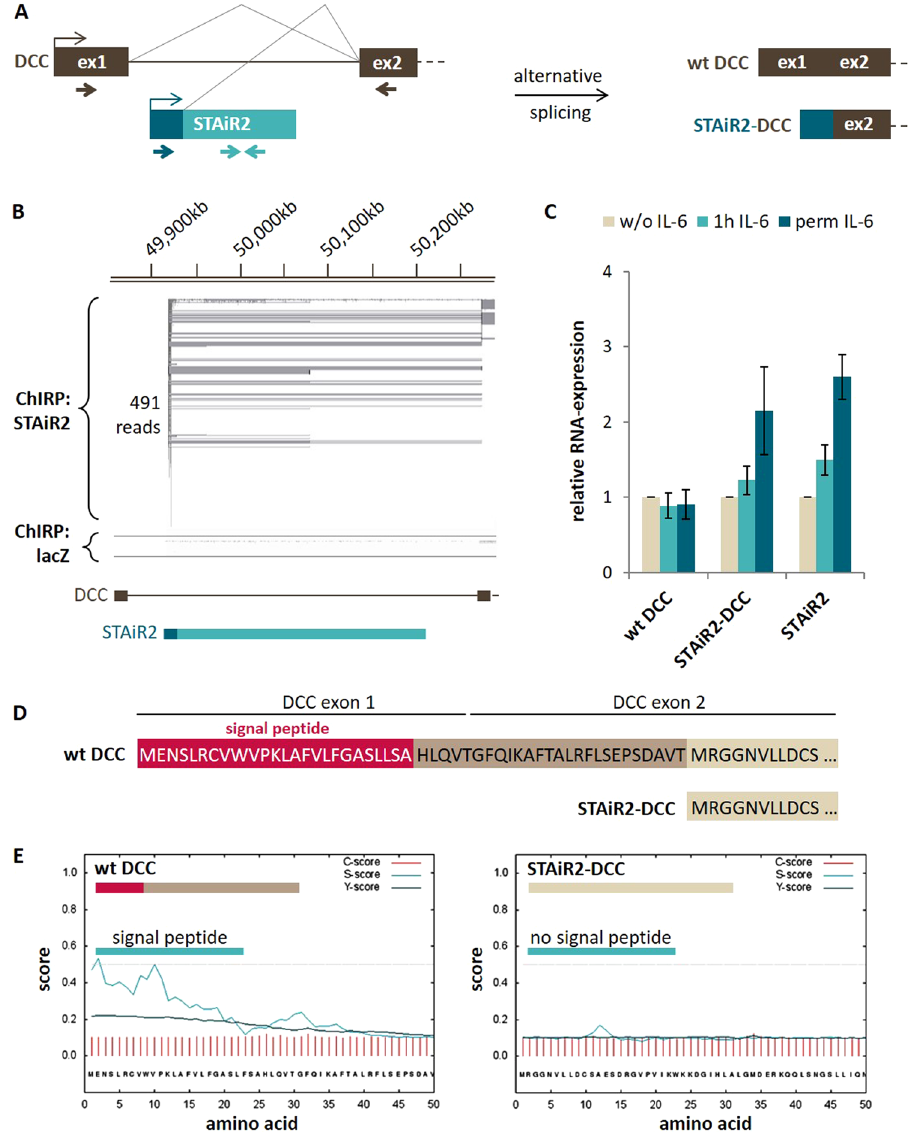
Figure 5. Alternative splicing of DCC and STAiR2 leads to an impaired DCC function. ( A ) Scheme of the alternative splicing event connecting the 5 ′ -region of STAiR2 with DCC exon2. Primer pairs used for variant validation are indicated at the bottom (brown for wild type DCC, dark blue (forward) and brown (reverse) for STAiR2-DCC hybrid, and light blue for STAiR2). ( B ) ChIRP-seq data of STAiR2 confirming a splice event from STAiR2 5 ′ -region and DCC exon2. STAiR2-ChIRP-seq was performed as described in Fig. 4. Gained reads for the STAiR2 locus were visualized by IGV compared to reads detected after lacZ negative control. The location of DCC host gene and STAiR2 ncRNA are shown at the bottom. ( C ) Validation of STAiR2-DCC hybrid. DNase- digested total RNA of withdrawn, 1 h IL-6 restimulated and permanently IL-6 treated INA-6 cells was reverse- transcribed and subjected to qPCR using specific primers shown in Fig. 5A. Expression values were normalized to U6 RNA and compared to the unstimulated control sample. Data are expressed as mean ± SD (n ≥ 3). ( D ) In frame open reading frames of the N-terminal regions of wild type DCC and STAiR2-DCC hybrid analyzed by NCBI ORF Finder. STAiR2-DCC hybrid depicts a downstream translational start site and lacks the signal peptide sequence (red) exclusively present in wild type DCC. ( E ) Analysis of the first 50 amino acids of wild type DCC (left) and STAiR2-DCC hybrid (right) by SignalP-4.1, a software to check for signal peptides. The C-score (red lines) detects signal peptide cleavage sites, the S-score (light blue line) detects the signal peptide position and the Y-score (dark blue line) is the geometric average of both